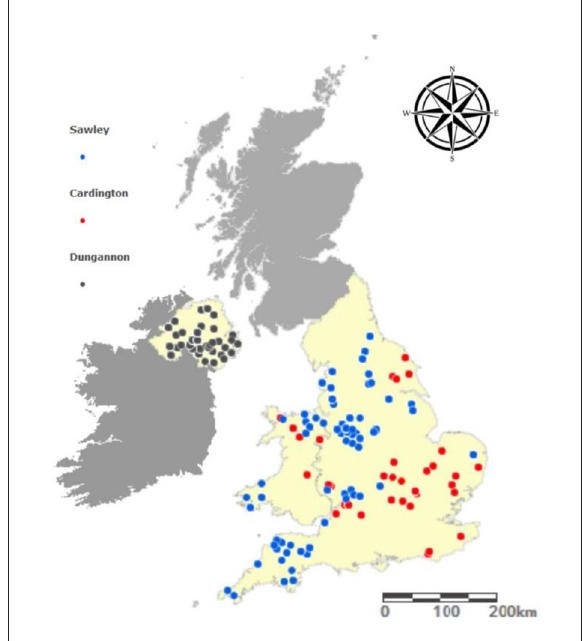
FIGURE1 The geographic origin of cattle carcases sampled from each of the abattoir